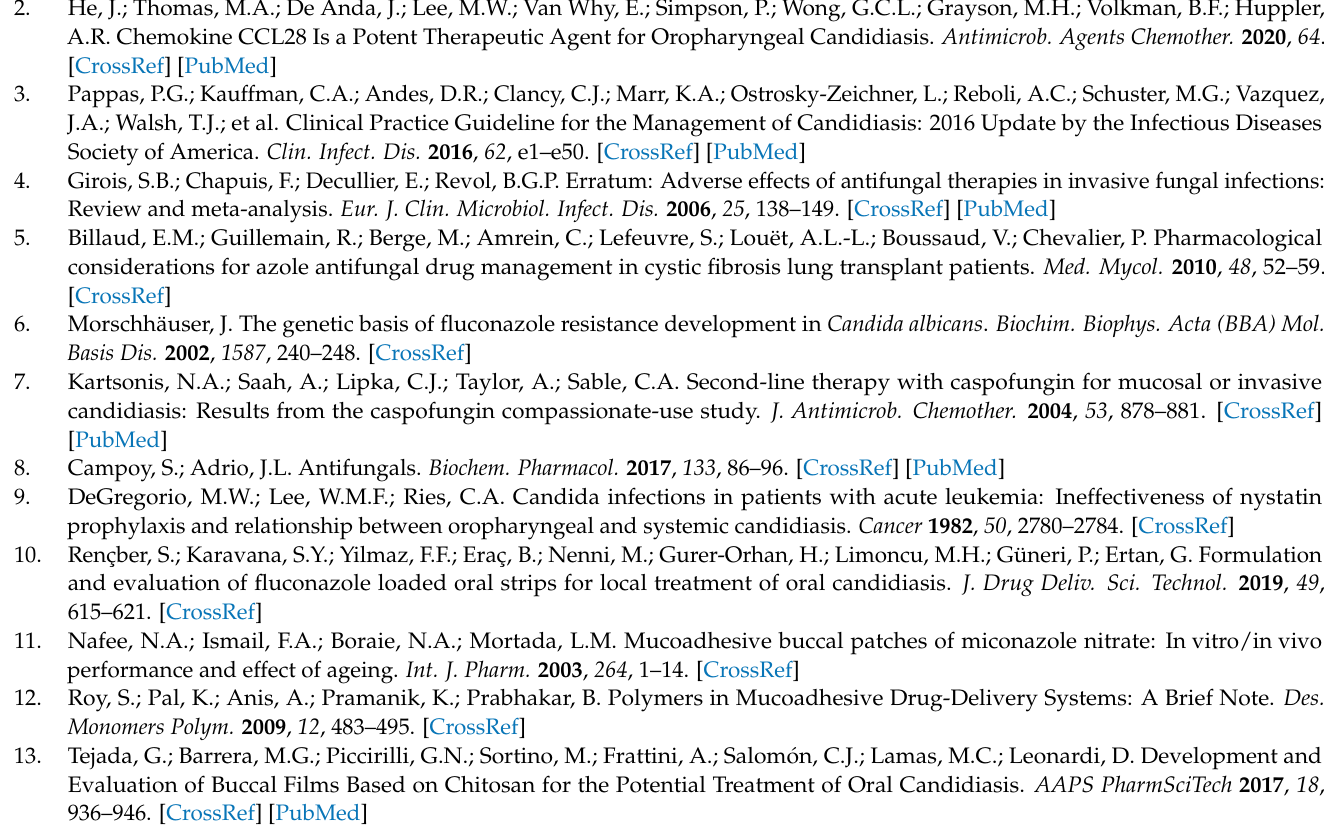
Figure S4: FTIR Spectra, Figure S5: DSC thermograms. Table S1: DSC Melting peaks obtained,